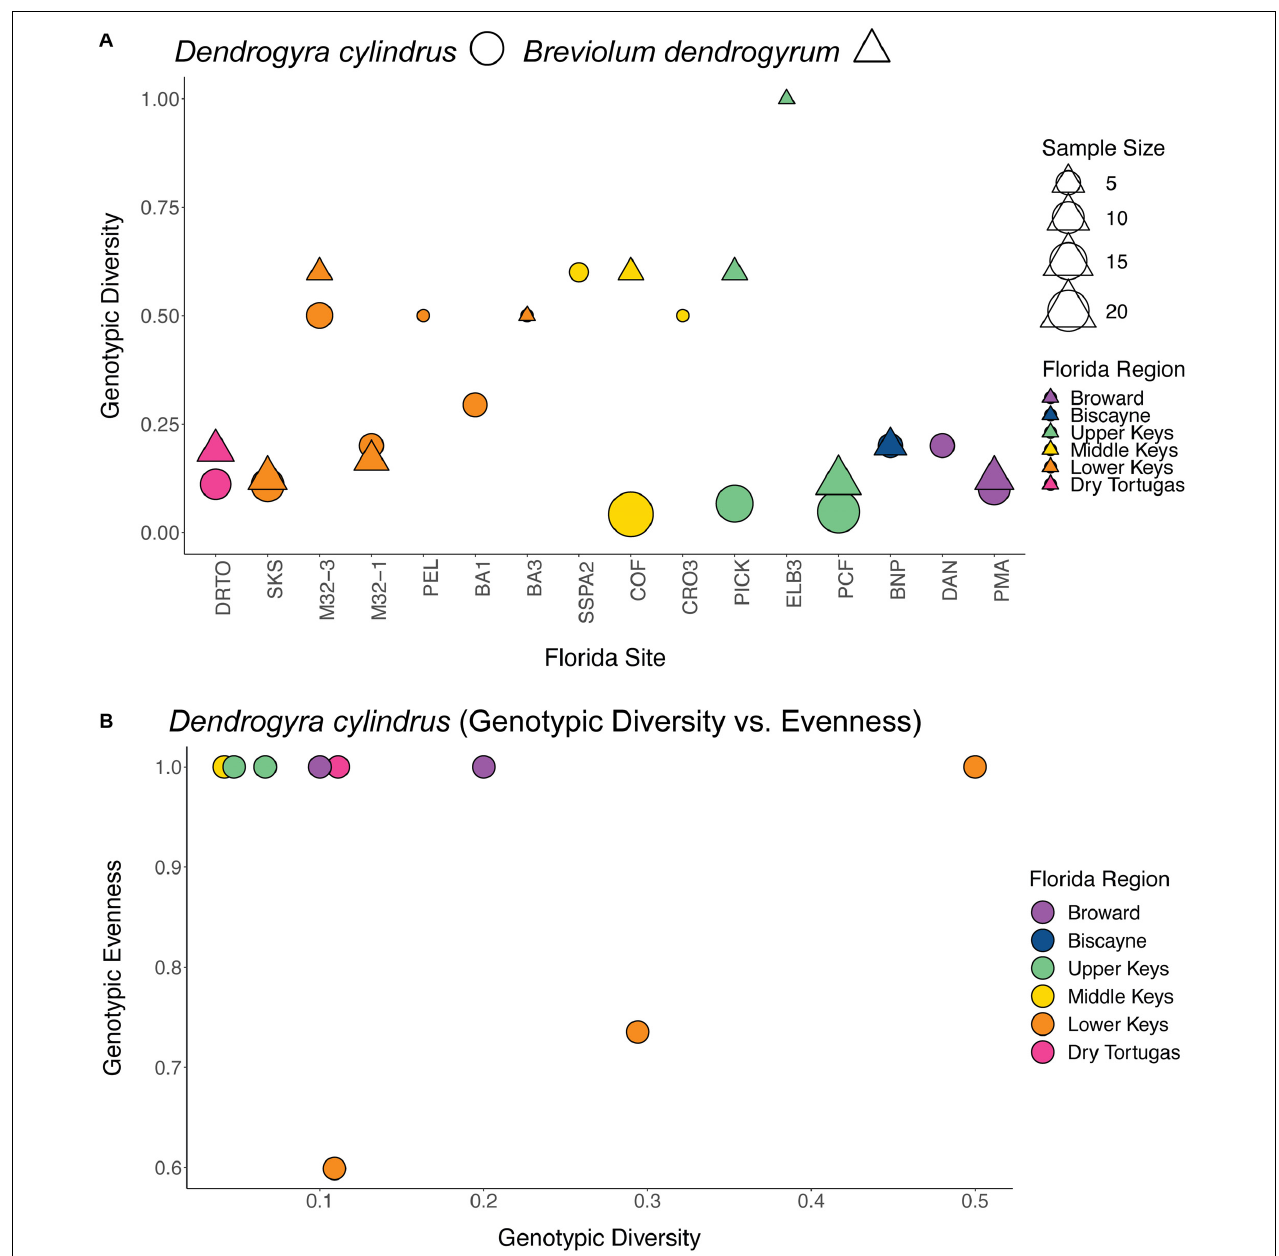
FIGURE 3 | Plots of genotypic diversity by Florida site for the coral host (circles) and symbiont (triangles) (A) , and a plot of genotypic diversity vs. evenness for the coral host (B) . Only sites with multiple genotyped colonies were included, with symbols scaled to sample sizes in (A) . For panel (B) , only sites with at least five samples genotyped were included. Sites are colored by region as in Figure 1